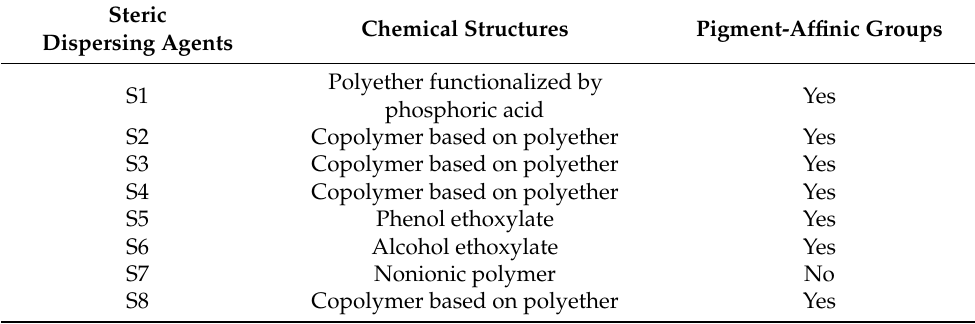
Chemical Structures